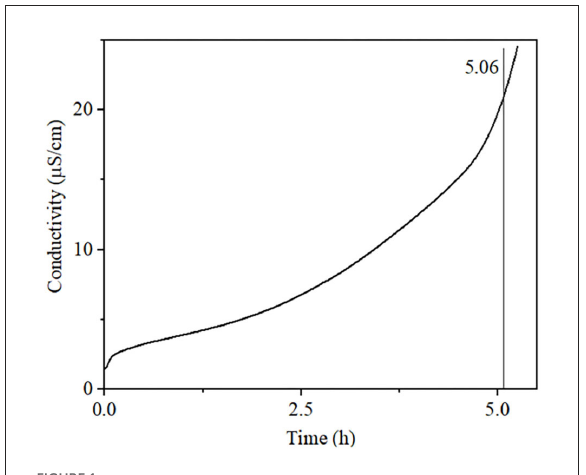
FIGURE1 Conductivity vs. time determined by the Rancimat method. Oxidation stability of sunflower oil conducted at 110 ◦ C with an airflow of 10 L h − 1